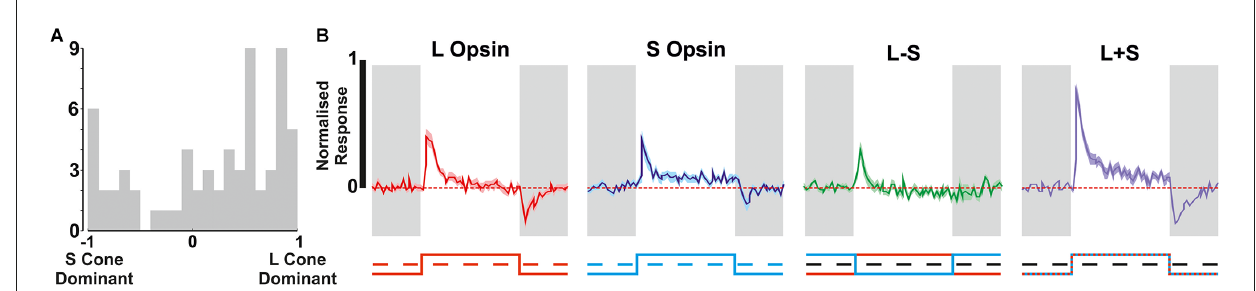
FIGURE5 Cone mediated responses in the second subpopulation of ipRGCs. (A) Distribution of S- vs. L- cone preference across putative non-M1 ipRGCs isolated using Mel High vs. Low steps. (B) Mean ± SEM cones responses of the putative non-M1 ipRGC population to various cone isolating stimuli ( n = 66).